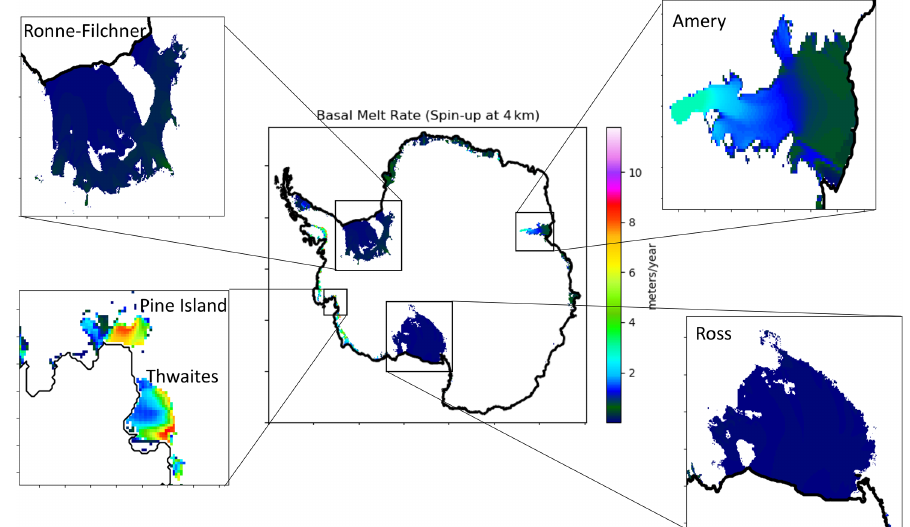
Figure 7. Basal melt rate at the end of spin-up at a 4km resolution for the all floating ice areas. Zoomed-in regions include the Pine Island Glacier/Thwaites region and Filchner–Ronne, Amery, and Ross ice shelves.